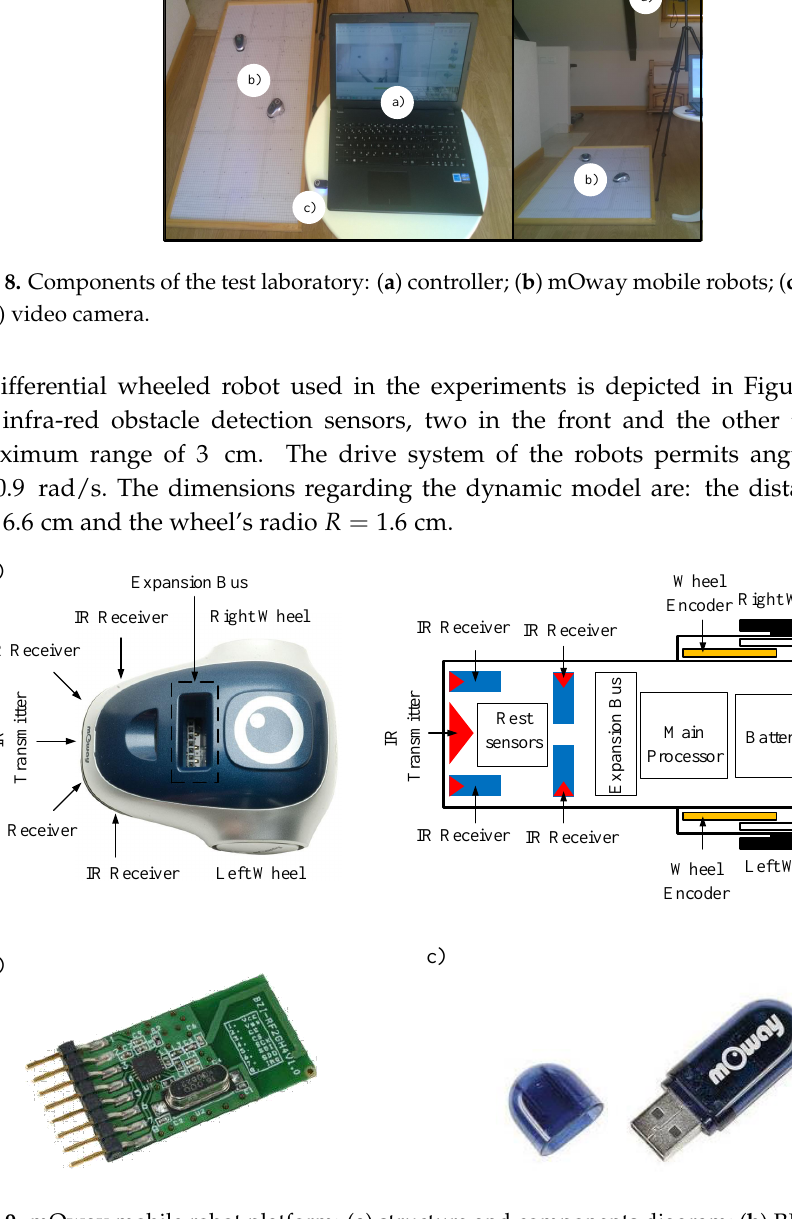
Figure 9. mOway mobile robot platform: ( a ) structure and components diagram; ( b ) RF module; and ( c ) RF USB